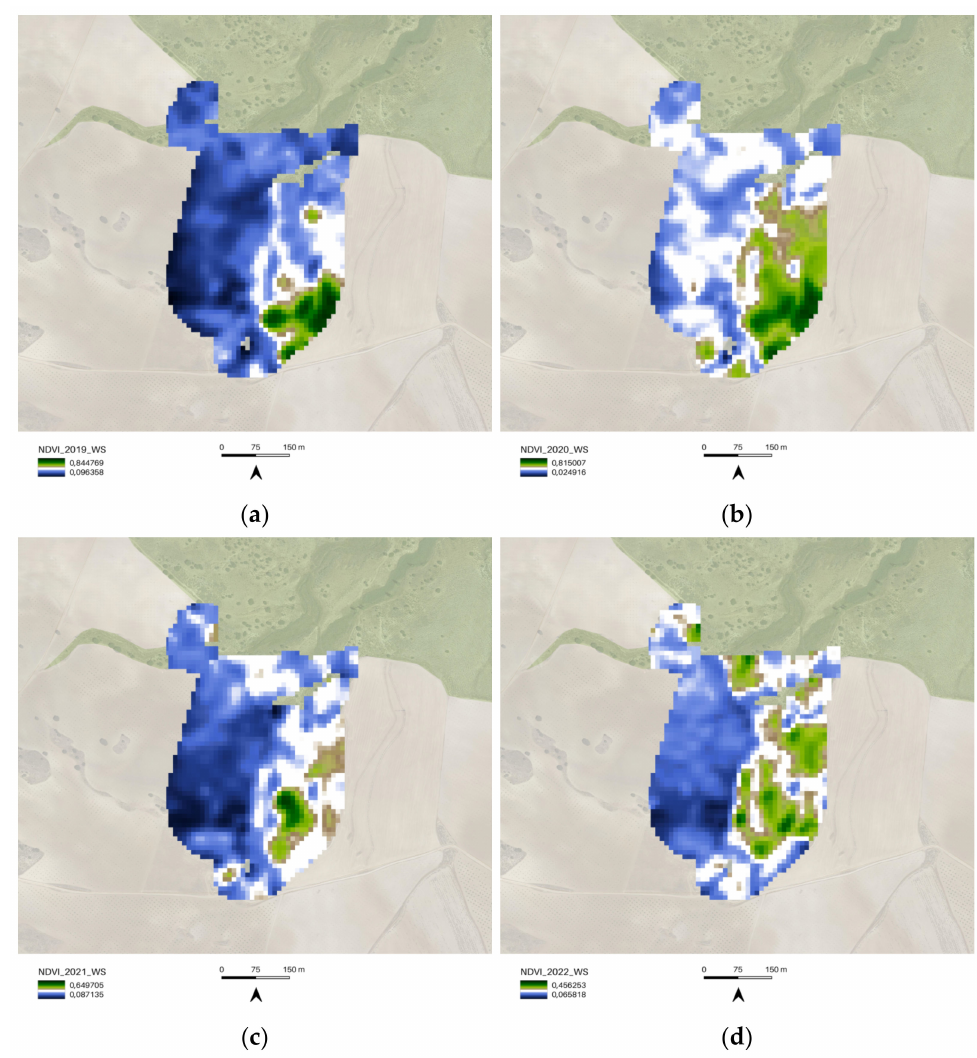
Figure 13. Camp_Altiplano_area.shp COPERNICUS/S2_SR NDVI; ( a ) 2019 COPERNICUS/S2_SR filter dates (YYYY-MM-DD) WS start 2018-12-01, WS end 2019-03-01; ( b ) 2020 COPERNICUS/S2_SR filter dates (YYYY-MM-DD) WS start 2019-12-01, WS end 2020-03-01; (c ) 2021